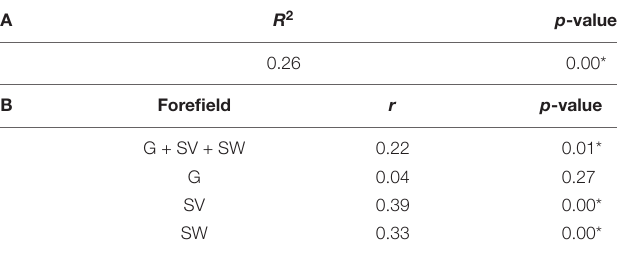
TABLE 2 | PERMANOVA performed between the distance from the ice edge and the geochemical dataset (A) . Mantel test performed to calculate the correlation between the distance from the ice edge and the geochemical dataset (i.e., TN + TOC) for the samples from the three different proglacial systems (G + SV + SW), only the G system, only the SV system, and only the SW system (B) . The symbol ∗ is reported for significant R 2 and r values where the statistic p -value <